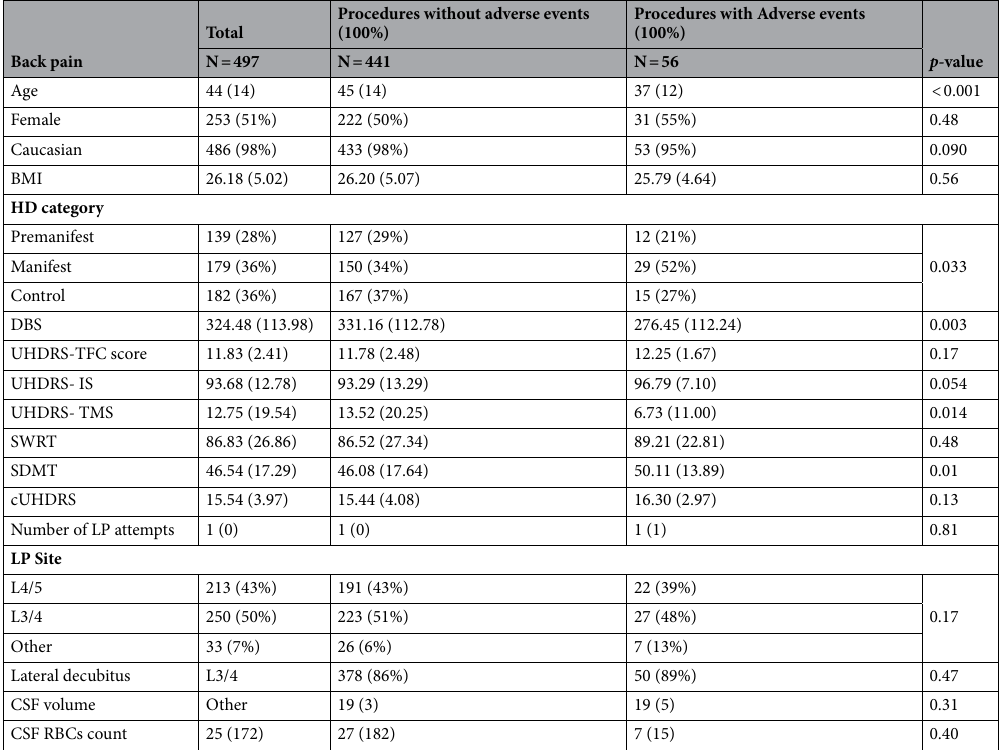
Table 6. Baseline demographics and CSF sample methodology in relation to the development of back pain post LP. Continuous variables are reported as mean (standard deviations). Categorical variables are reported as absolute and relative frequencies. SD Standard deviation, BMI body mass index, CAG HTT CAG size, DBS Disease Burden Score, cUHDRS composite Unified Huntington’s Disease Rating Scale, TMS UHDRS Total Motor Score, TFC UHDRS TotalFunctional Capacity, IS UHDRS Independence Scale, SWR Stroop Word Reading test, SDMT Symbol Digits Modality Test, RBCs Red Blood Cells.